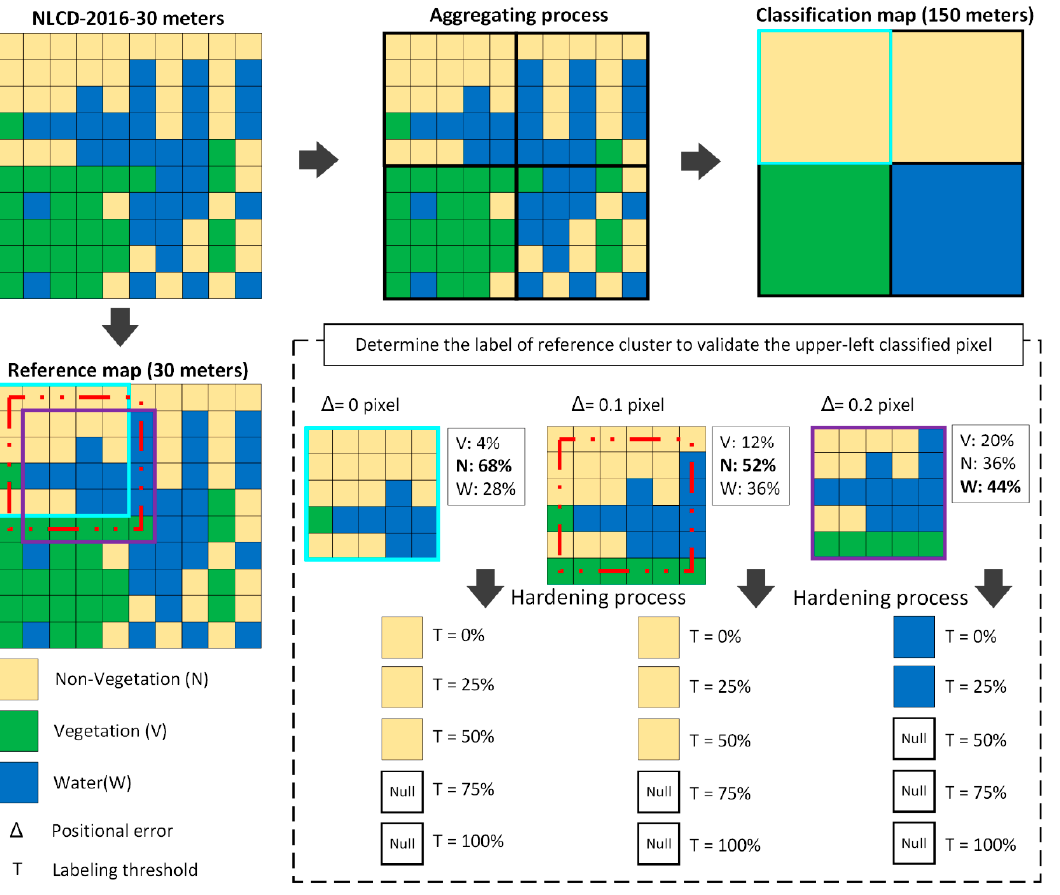
labeling thresholds